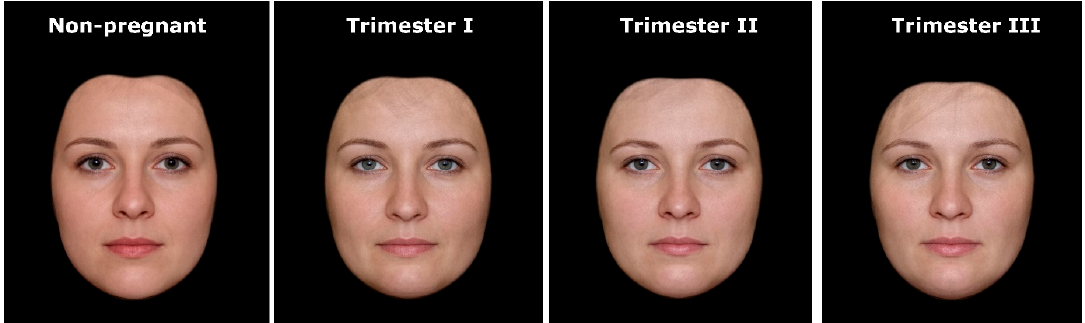
Figure 1. Stimuli used in the study—composite portraits of women’s faces in relation to pregnancy status and progress.